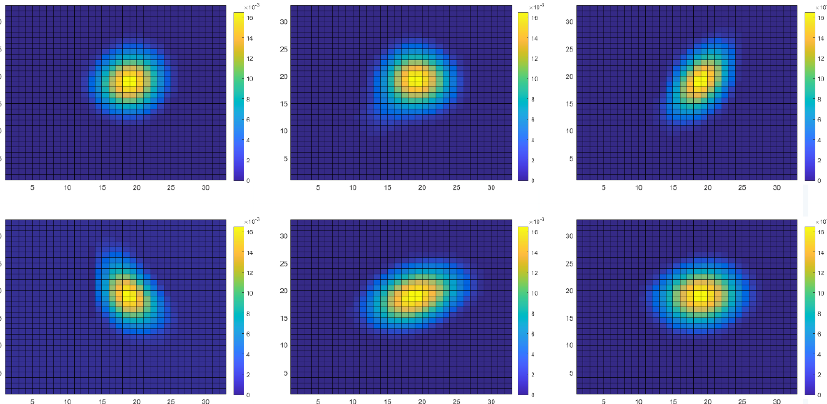
Figure 6. Graphical example of a degradation kernel extracted after KernelGAN